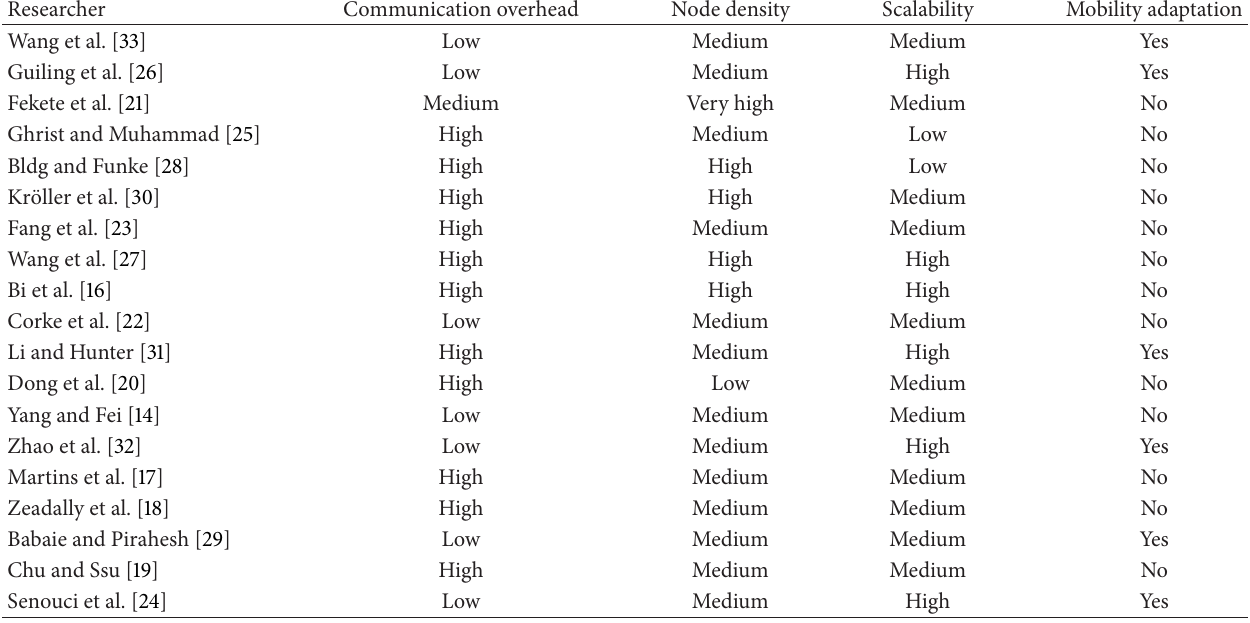
Table 3: Comparison of hole detection algorithms under different parameters.